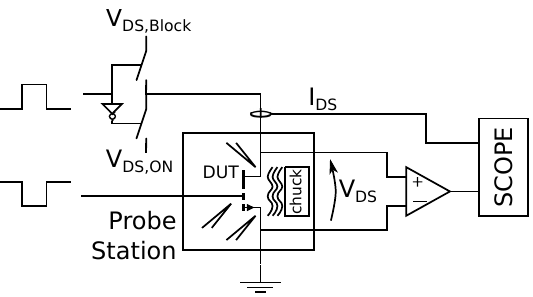
Figure 3. Functional simplified description of the setup.